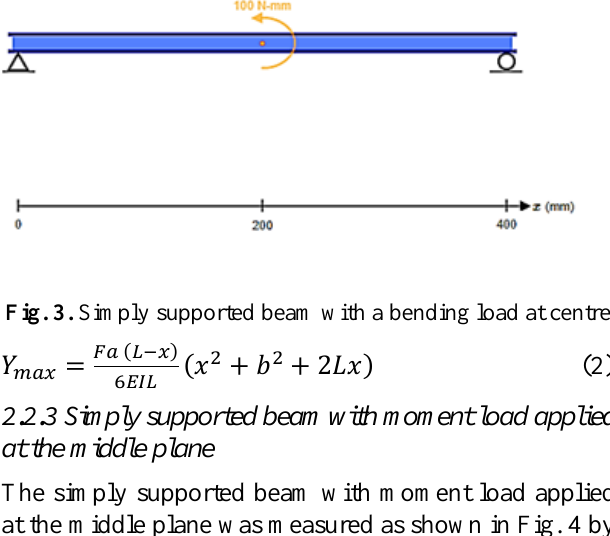
Fig. 1. Geometry and dimensions of cemented carbide by SolidWorks program